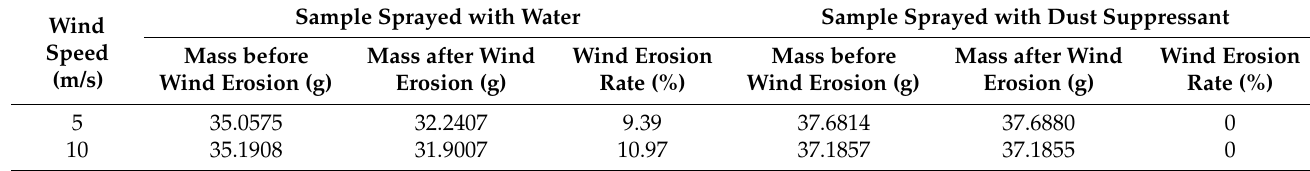
Table 9. Results for wind erosion resistance